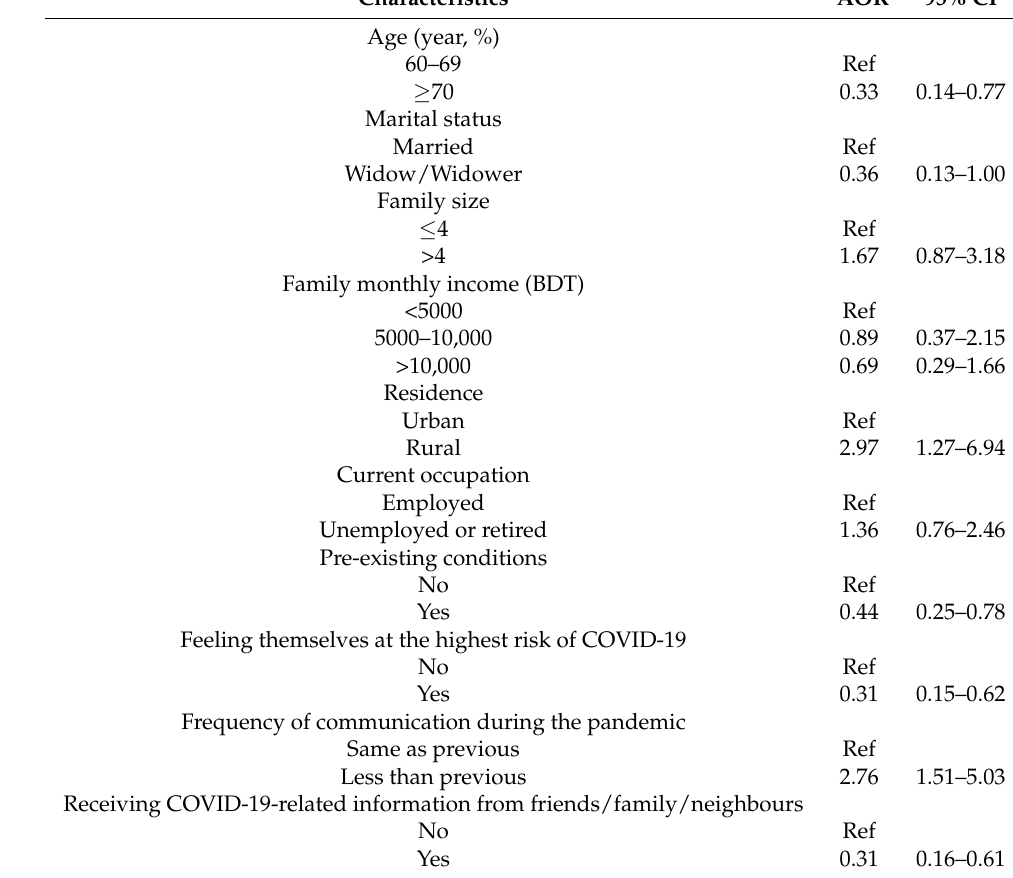
Table 2. Factors associated with increased tobacco use during